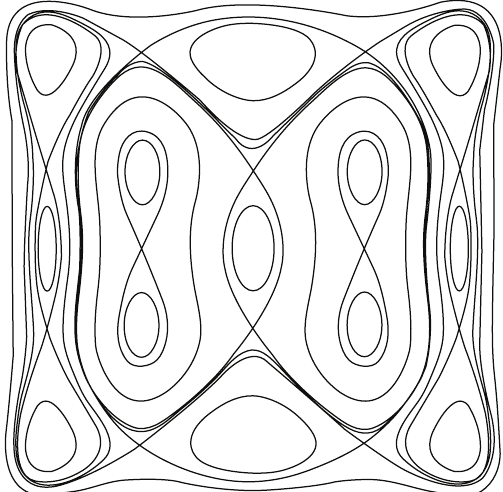
Figure 2: Families of closed orbits defined by system ((10a) and (10b)) with UP is